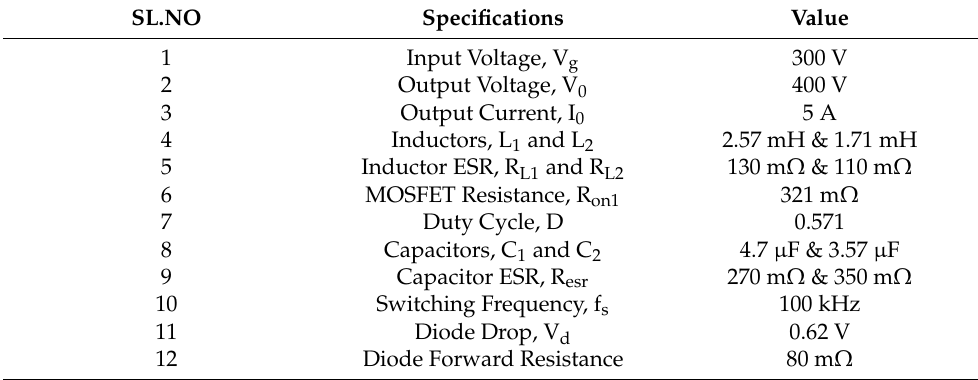
Table 2. Specifications of non-ideal SEPIC.